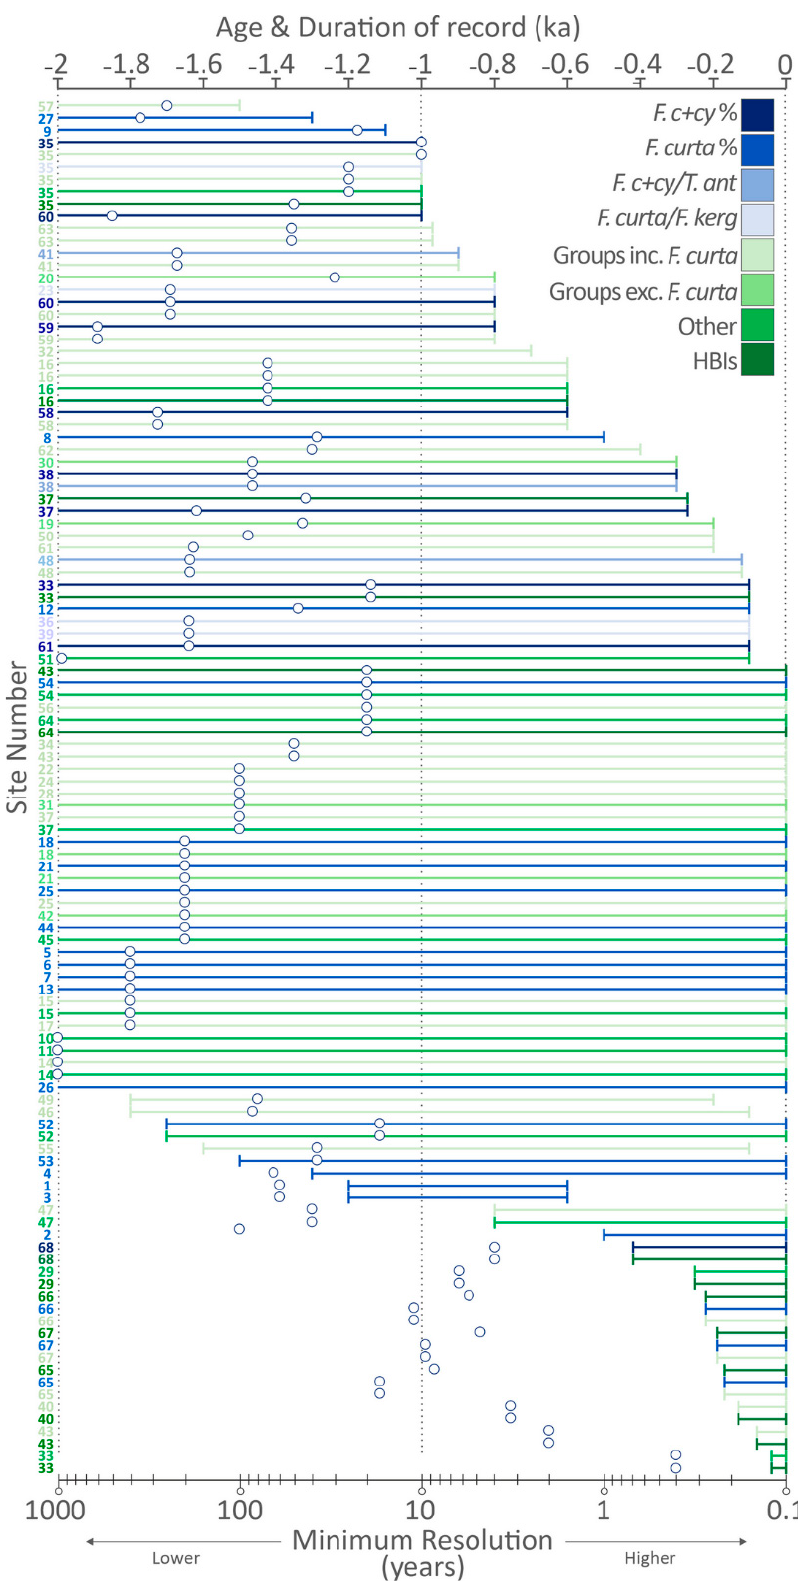
Figure 12. Plot showing the age, duration (horizontal lines, upper axis), and minimum resolution (open circles, bottom axis) for all downcore proxy records (site numbers, left axis) of sea ice included in this review.